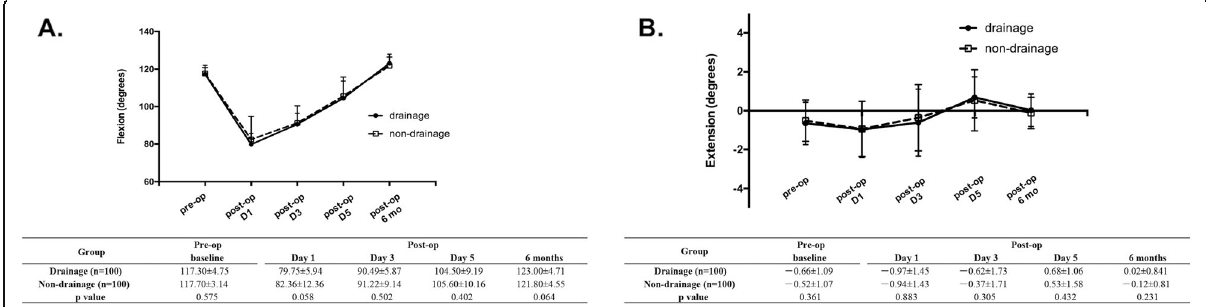
Fig. 4 Effect of drainage on ROM after TKA. a . flexion degree; b . extension degree